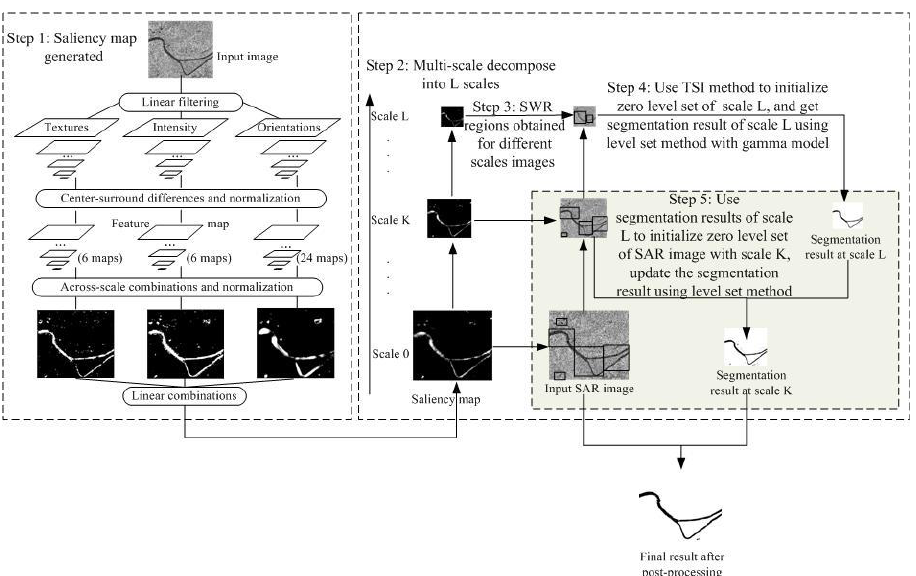
Figure 1. The basic principle of the proposed method. (Step1, saliency map generated from original image; Step 2, Decomposed the saliency map into L scales; Step3, Obtained SWR regions in different scales; Step4, Segmented the water in SWR regions; Step5, refine the segmented result; Step6, post-processing to acquire accurate water